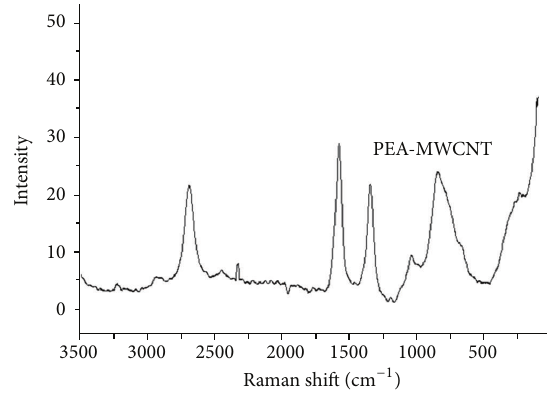
Figure 4: Fourier transform infrared (FTIR) spectra of PEA- MWCNT.